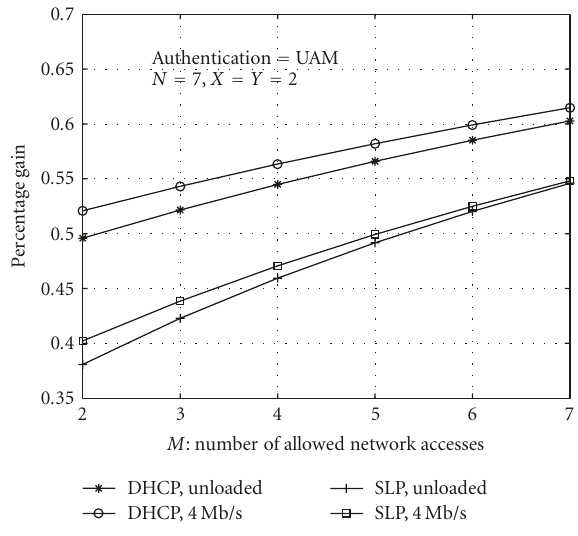
discovery times obtained with the beacon-based service pub- lishing with respect to the legacy Try-and-See approach is